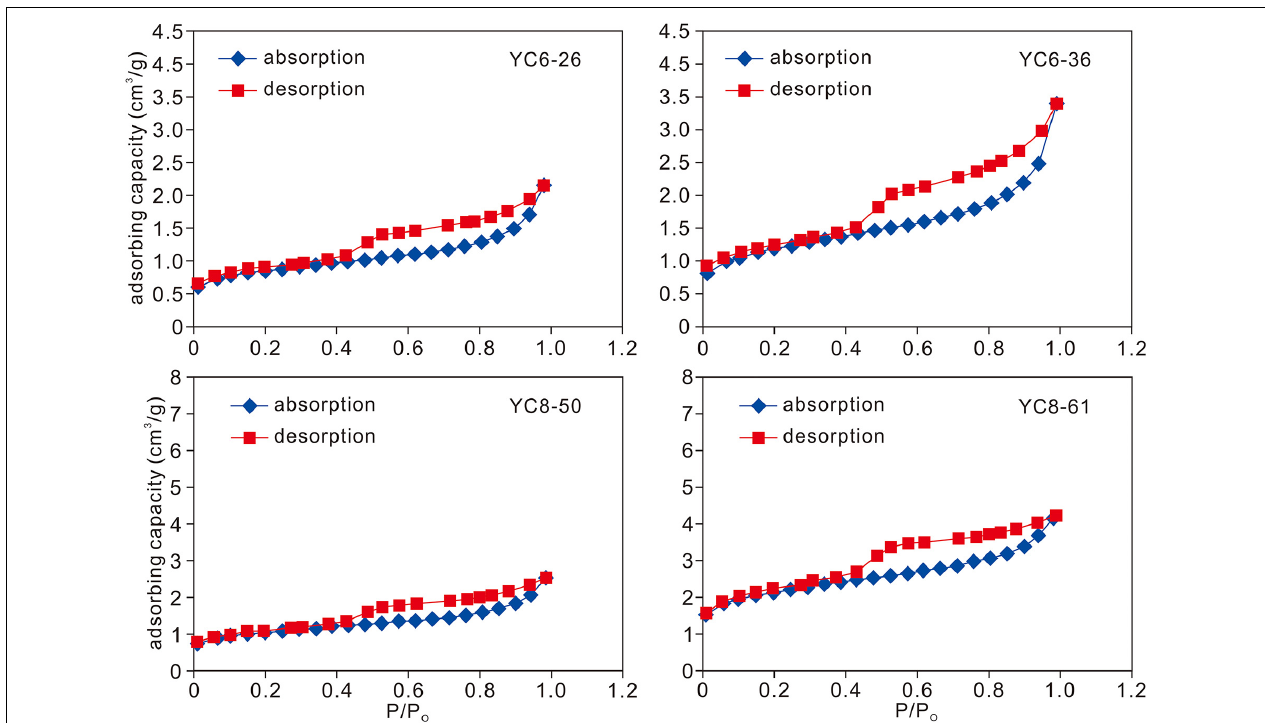
FIGURE 8 | Nitrogen gas adsorption/desorption curves of representative samples from YC 6 well and YC 8 well in the Wufeng–Longmaxi